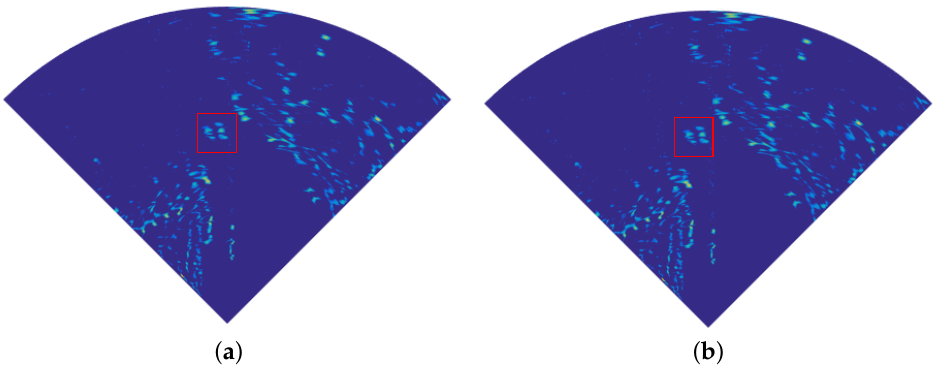
Figure 11. Experiment data processing results. ( a ) The processing result using Matlab. ( b ) The processing results obtained using the